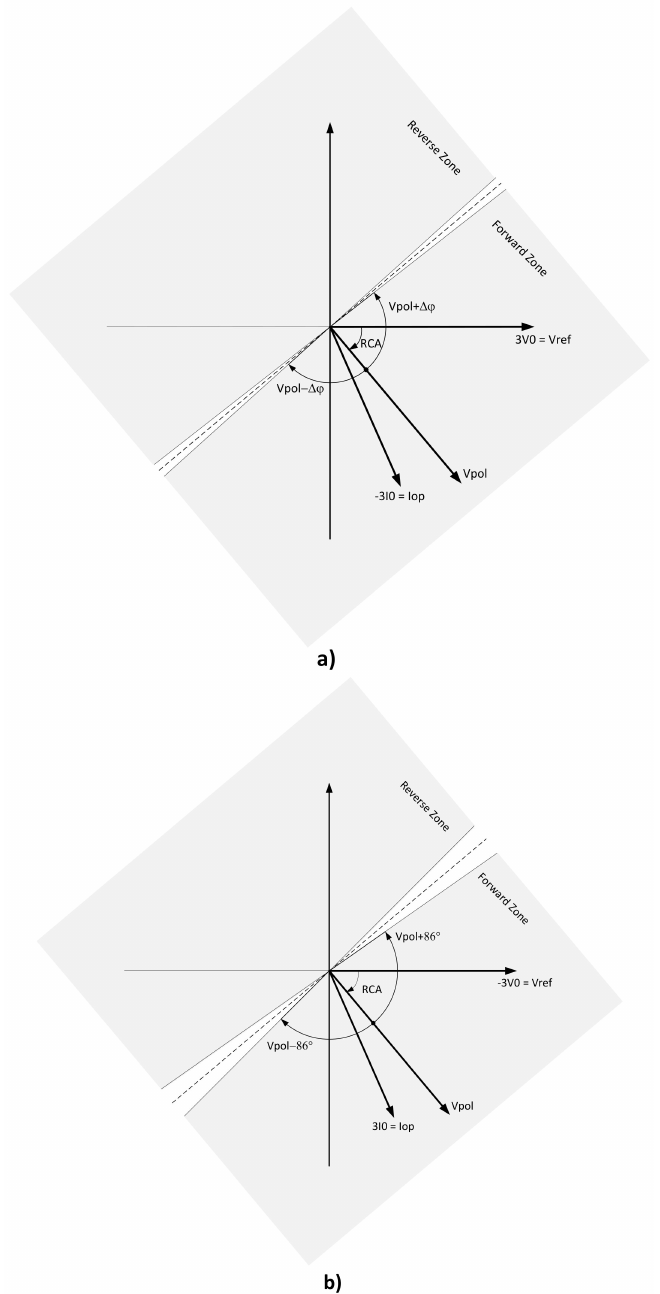
Figure 2. Direction determination characteristic for zero-sequence quantities in relays ( a ) SIEMENS 7SJ85 and ( b ) ABB